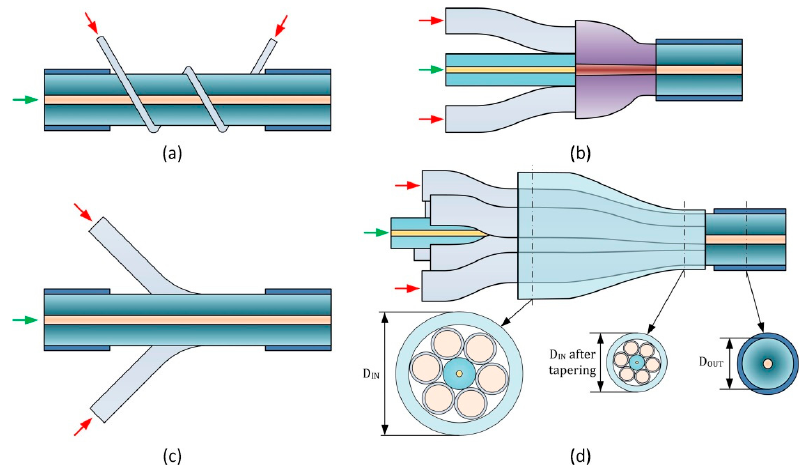
Figure 1. Power combiner realization schemes: Distributed side coupling ( a ), end-pumping through fused fiber bundle and tapered bridging fiber ( b ), conventional side coupling ( c ), and end-pumping through tapered fused fiber bundle ( d ).